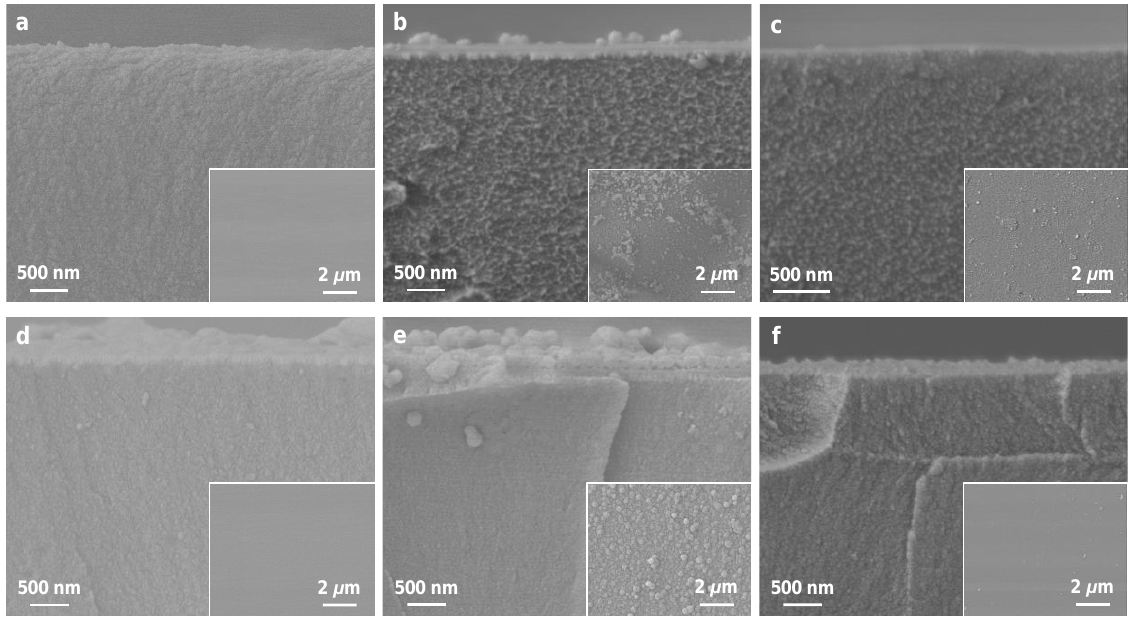
Figure 5. Cross-sectional SEM images of ( a ) X-PI(370), ( b ) as-prepared and ( c ) acid-treated X- PI(370)/ZIF-8, ( d ) X-PI(420), ( e ) as-prepared X-PI(420)/ZIF-8, and ( f ) acid-treated X-PI(420)/ZIF-8. The inset images are the corresponding top views.